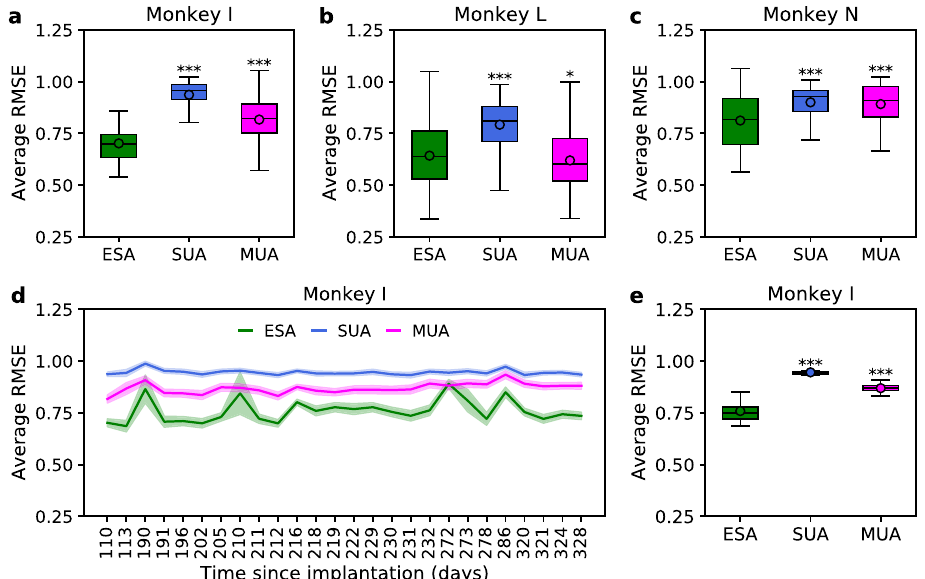
Figure 3. Comparison of inference performance in terms of average RMSE among different types of spiking activity across three subjects. ( a – c ) Boxplot comparison of average RMSE among ESA, SUA, and MUA from monkey I, L, and N, respectively. ( d ) Comparison of average RMSE among ESA, SUA, and MUA from monkey I over 26 recording sessions. ( e ) Boxplot comparison of average RMSE across 26 recording sessions. Asterisks indicate spiking activity whose inference performance differed significantly from that of ESA (* p < 0.05, *** p < 0.001